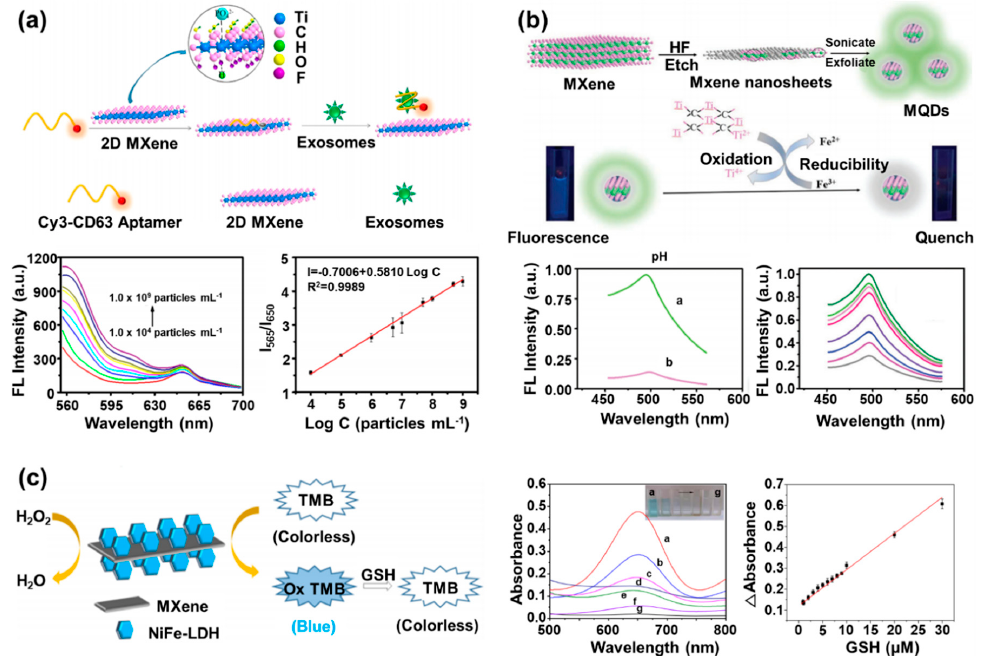
Figure 4. MXene-based fluorescent/optical biosensors. ( a ) Schematic image of the fluorescence resonance energy transfer (FRET)-based biosensing system based on the MXene nanosheets combined with Cy3-labeled CD63 aptamer and fluorescence signal of Cy3-labeled CD63 aptamer with different exosome concentrations and its linear calibration curve (reprinted with permission from [54]; copyright (2018) American Chemical Society). ( b ) Schematic images of the synthesis process of the MQDs and its Fe 3+ detection mechanism, the fluorescence signal of the MQDs with or without 100 μ M Fe 3+ , and the fluorescence signal of MQDs with different concentrations of Fe 3+ (reprinted with permission from [55]; copyright (2020) The Royal Society of Chemistry). ( c ) Schematic image of the MXene nanosheet and the Ni, Fe layered double hydroxide (NiFe-LDH) (MXene / NiFe-LDH)-based colorimetric biosensor for glutathione (GSH) detection and absorbance spectrum of di ff erent configurations of MXene / NiFe-LDH in tetramethylbenzidine (TMB) and H 2 O 2 with change of color and its linear calibration curve (reprinted with permission from [56]; copyright (2019) American Chemical